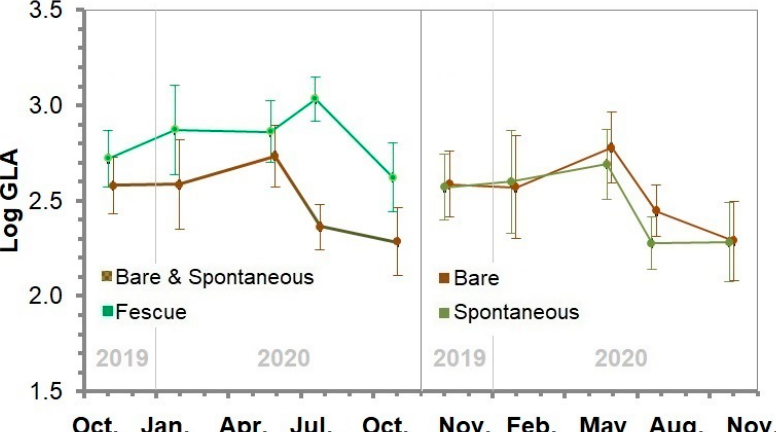
Figure 6. Logarithm to base 10 of the β -D-glucosidase activity (GLA) at 0–20 cm in the different treatments throughout five sampling dates during the monitoring time alongside the respective 95% confidence intervals according to the orthogonal contrasts based on the one-way ANOVAs results.